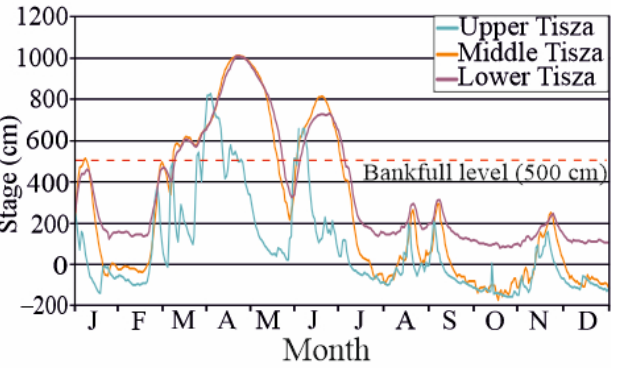
Figure 2. Daily water stages measured in 2006 at the Upper, Middle and Lower Tisza.